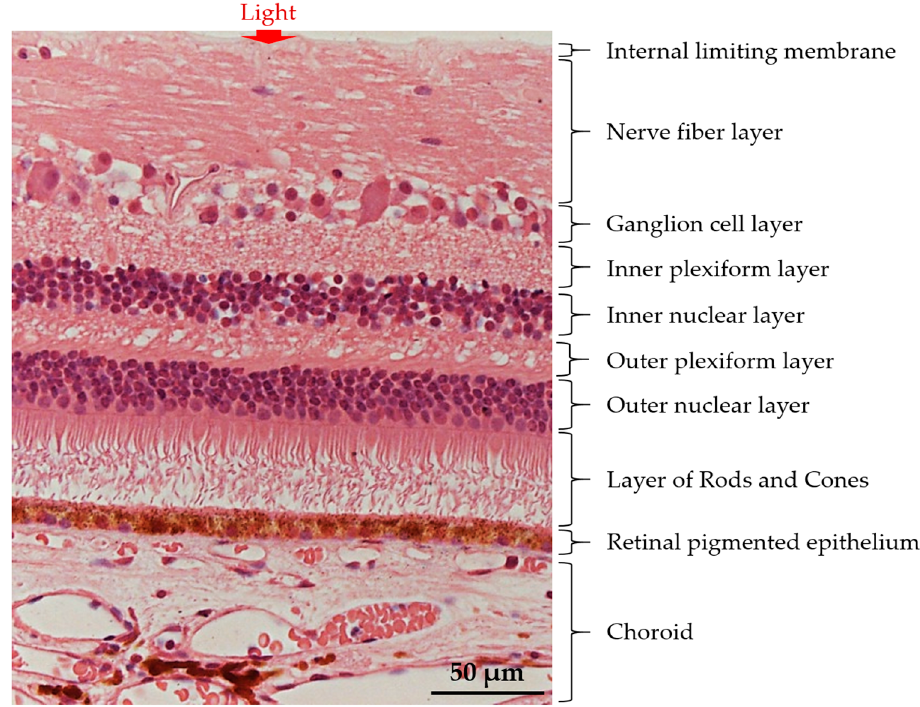
Figure 1. The basic retinal structure. Histological appearance of choroid and retinal layers. The retina is arranged in different layers of cells, from Retinal Pigment Epithelium (RPE), Outer Nuclear Layer (ONL), Outer Plexiform Layer (OPL), Inner Nuclear Layer (INL), Inner Plexiform Layer (IPL), and ganglion cell layer. The retinal layer harbors five retinal neuronal cells, primarily, the rod- and cone-photoreceptors, the Müller glia, the horizontal cell, the bipolar cell, the amacrine cell, and the Retinal Ganglion Cell (RGC). The arrow indicates the light transmission into the retina. Modified with permission from InTech’s Publishing Ethics and Legal Affairs Department [5] (© 2012 Triviño